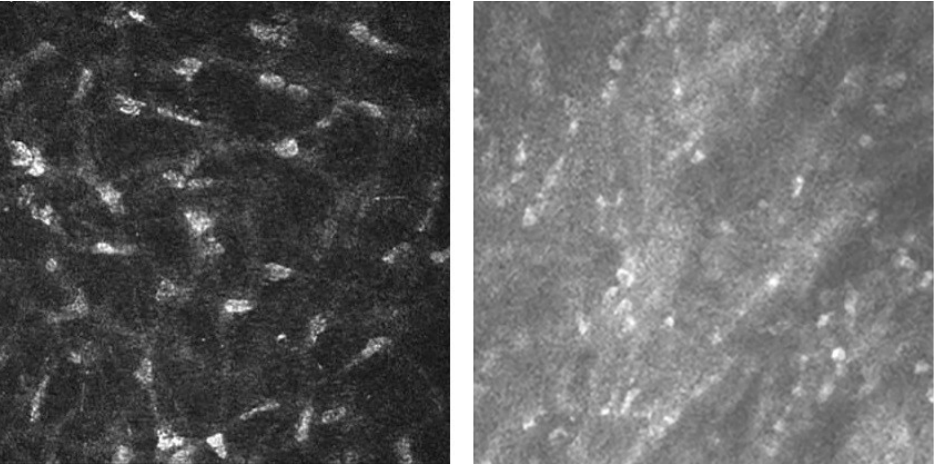
Figure 4. In vivo confocal microscopy of a normal human cornea at the stromal level ( left ); inflam- matory cells observed at the same level during active herpes keratitis ( right